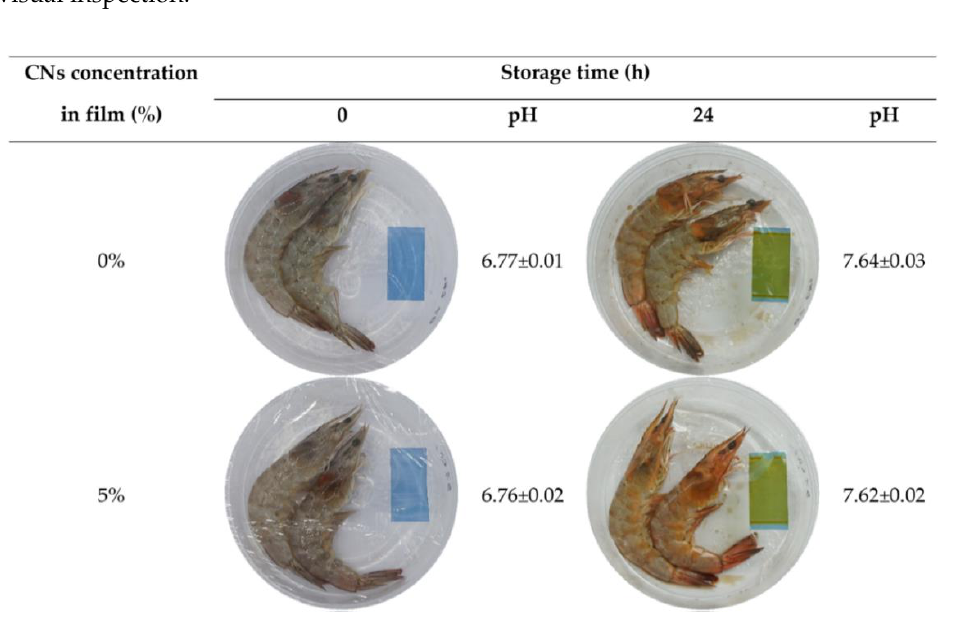
Figure 3. Application of a cellulose nanosphere (CNs)-containing smart bilayer film for monitoring changes in shrimp quality at 25 °C. 4. Conclusions The addition of butterfly pea anthocyanin extract and catechin – lysozyme to film formulations resulted in the successful preparation of a smart bilayer film. The smart bilayer film has a blue film color and has the ability to change colors depending on the pH level. Furthermore, it has the potential to change color when exposed to volatile ammonia and acid. The smart bilayer film is highly antioxidant and antimicrobial. Corncob cellulose nanospheres (CNs) can improve the mechanical properties of smart bilayer films without affecting their chemical properties. The smart bilayer film, containing all concentrations